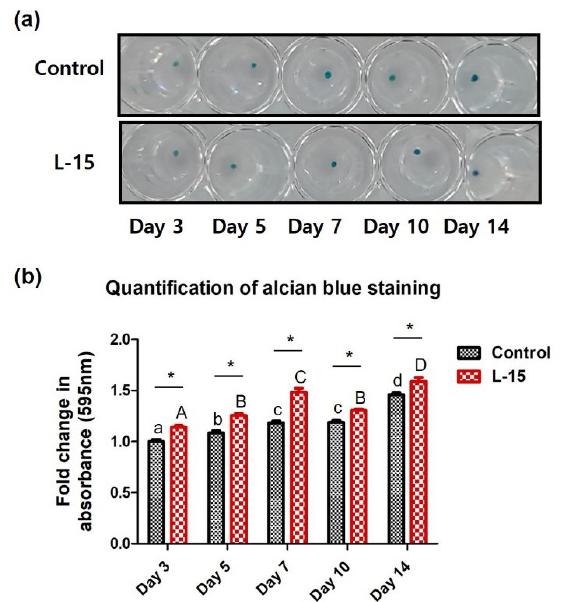
Figure 5. ( a ) Alcian blue staining of the control and L-15 extract-treated groups. ( b ) Quantitative measurements of alcian blue staining ( n = 3). Error bars represent mean ± S.D. A, B, C, and D values of different superscripts indicate significant difference between LET groups and a, b, c, and d values of different superscripts indicate significant difference between control groups (* p < 0.05); two-way ANOVA was used.